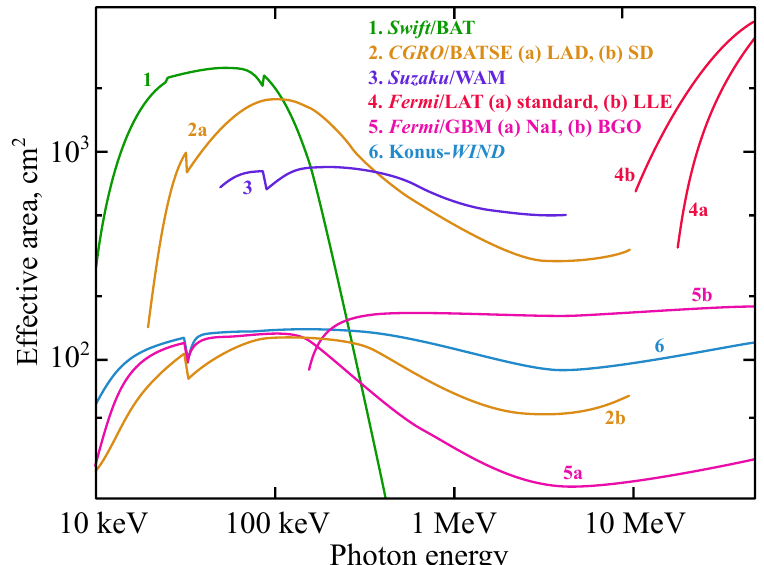
Figure 2. Comparison of the on-axis effective area of gamma-ray instruments with wide fields of view adapted from [24].